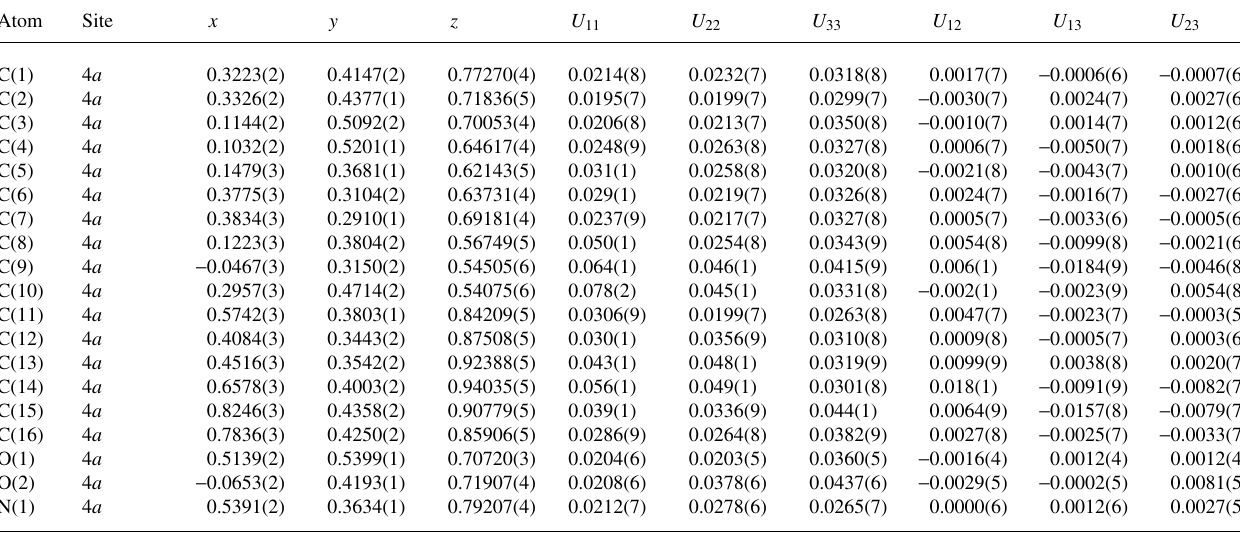
Table 3. Atomic coordinates and displacement parameters (in Å 2 )